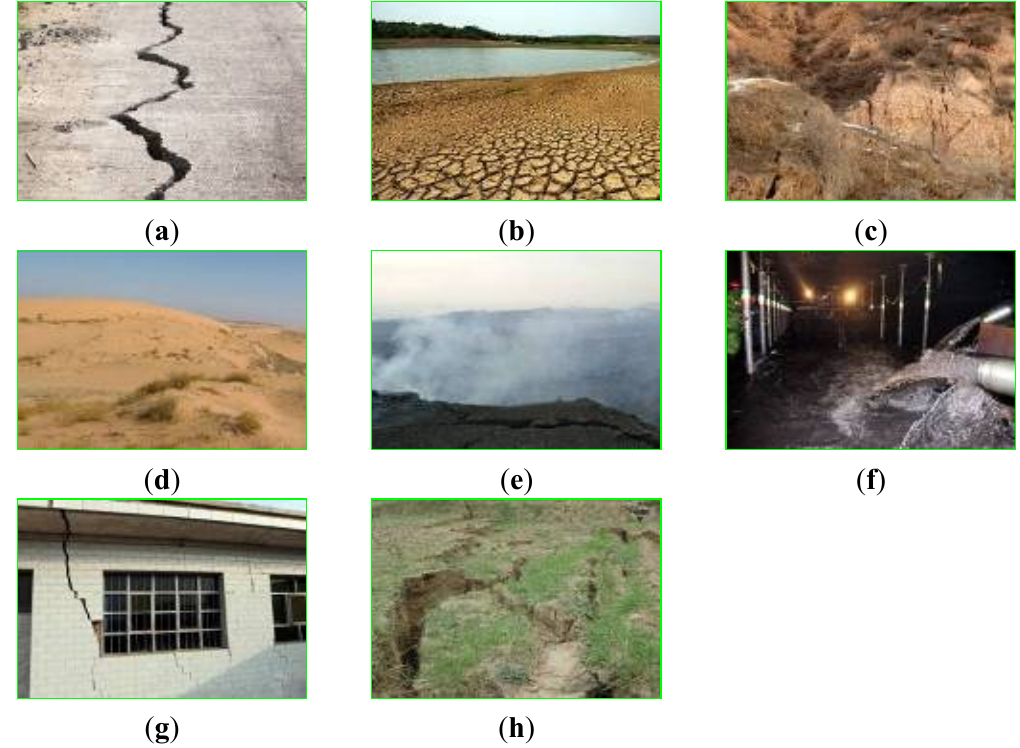
Figure 1. Mine safety and environmental issues due to underground coal mining: ( a ) formation of cracks on the surface; ( b ) water loss; ( c ) vegetation deterioration; ( d ) land desertification; ( e ) coal spontaneous combustion; ( f ) water inrush; ( g ) formation of cracks in architectural structures; and ( h ) farmland